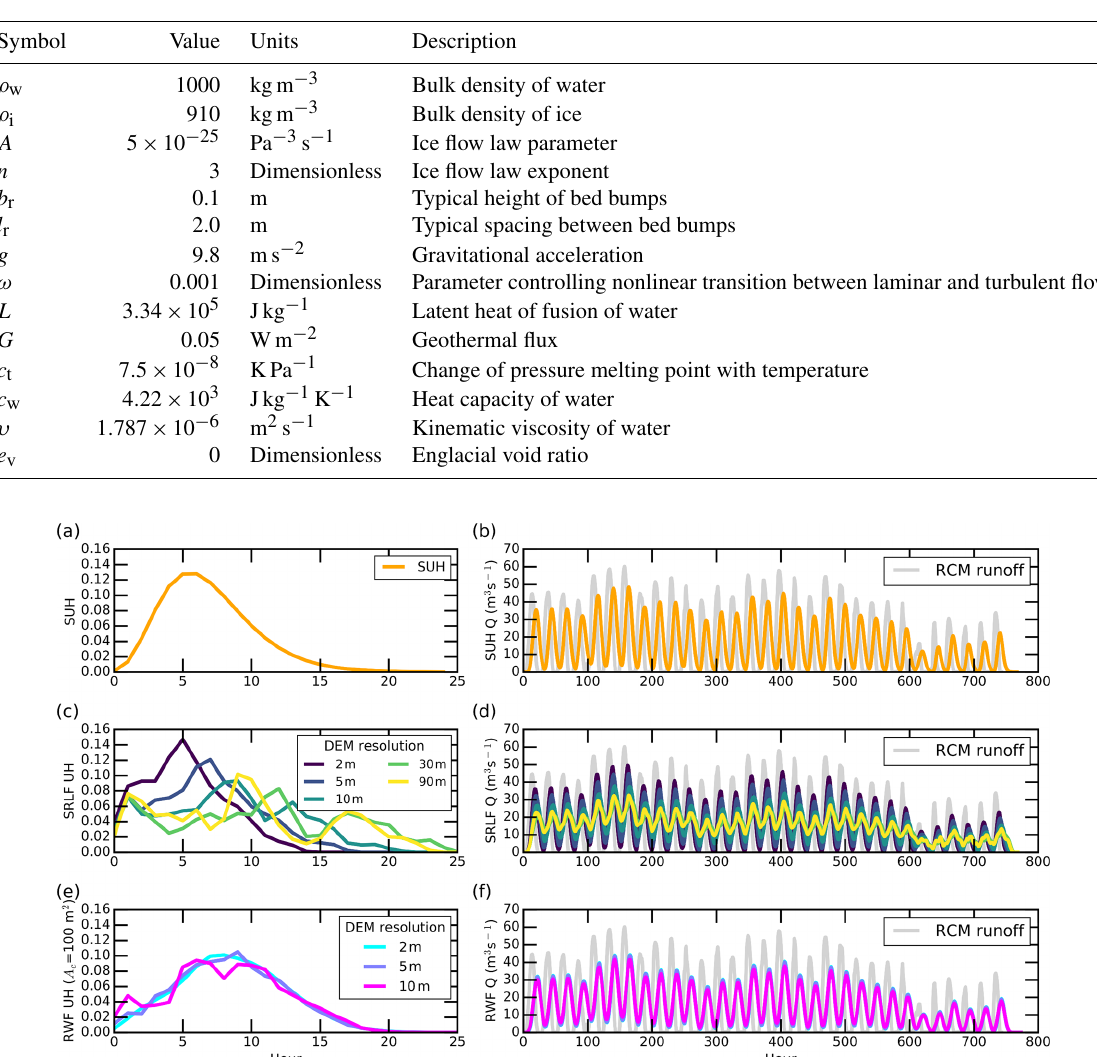
Table 3. Constants and parameters used in subglacial hydrology simulations.